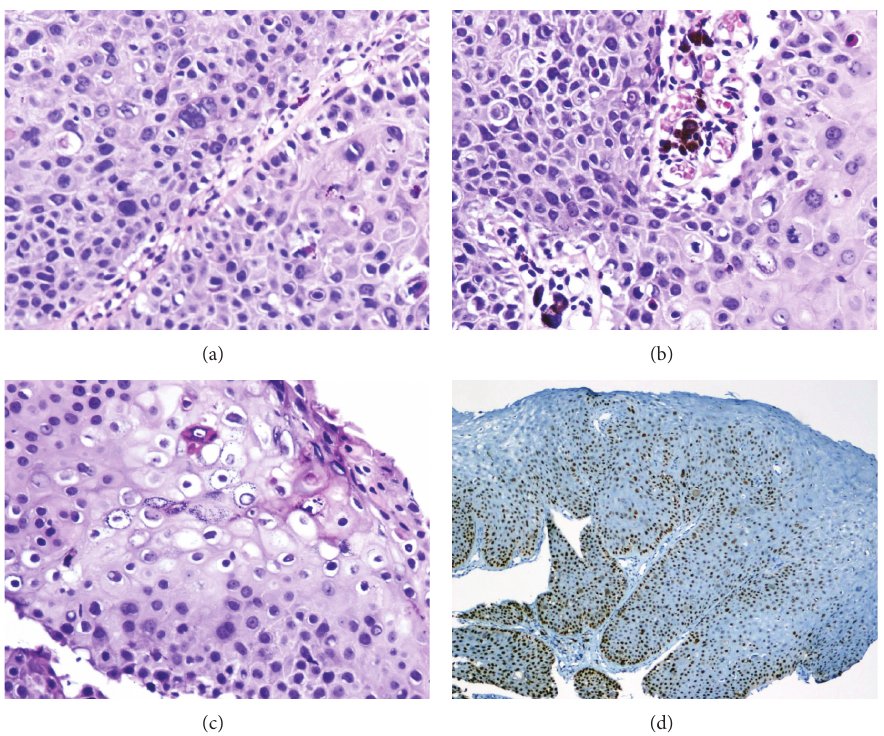
Figure 2: (a) Photomicrographs demonstrate cytologic atypia of tarsal tumor, right lower lid. (b) Pigmented melanophages within vascular cores imparting brown color to tumor. (c) Viral-containing koilocytes are present in outer tumor. (d) P53 immunostain is diffusely positive (hematoxylin/eosin (a)–(c) (×400) ; (d) immunostain, (×200)